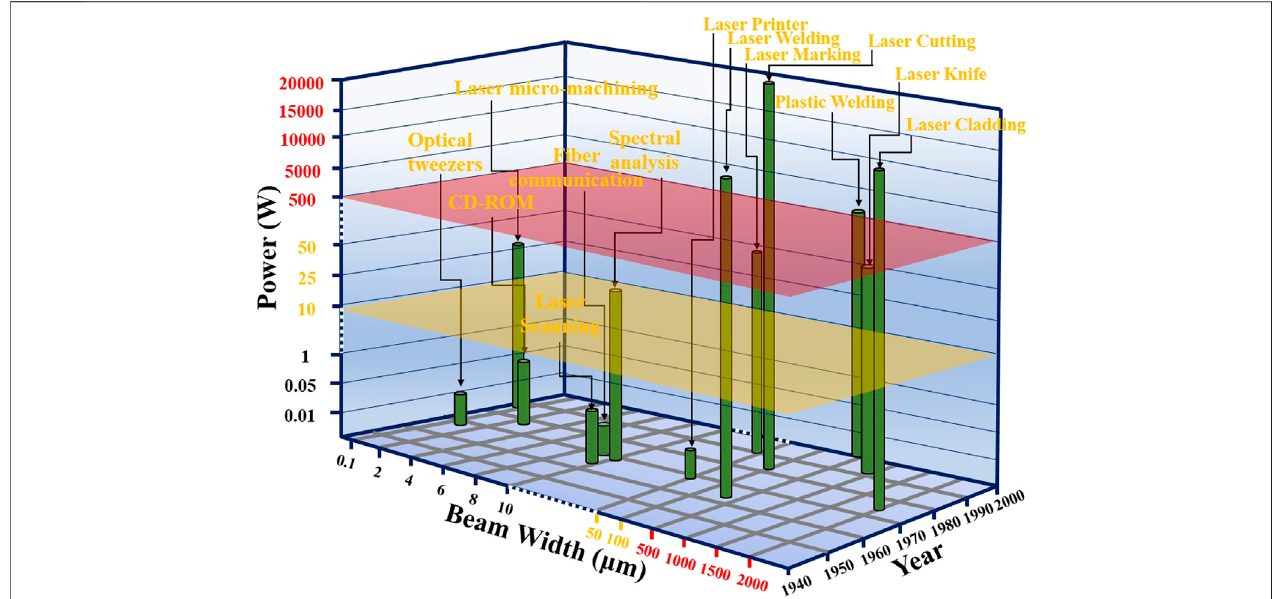
FIGURE 1 | Statistics of applications of the semiconductor